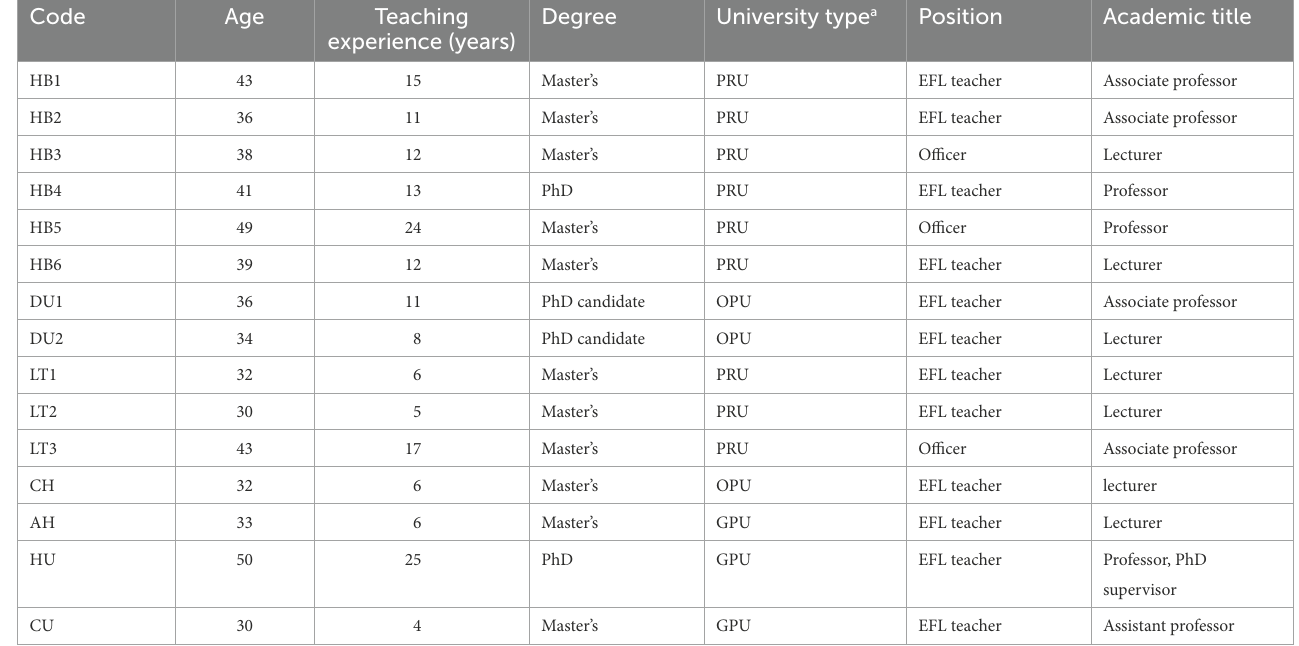
TABLE 2 Information of the